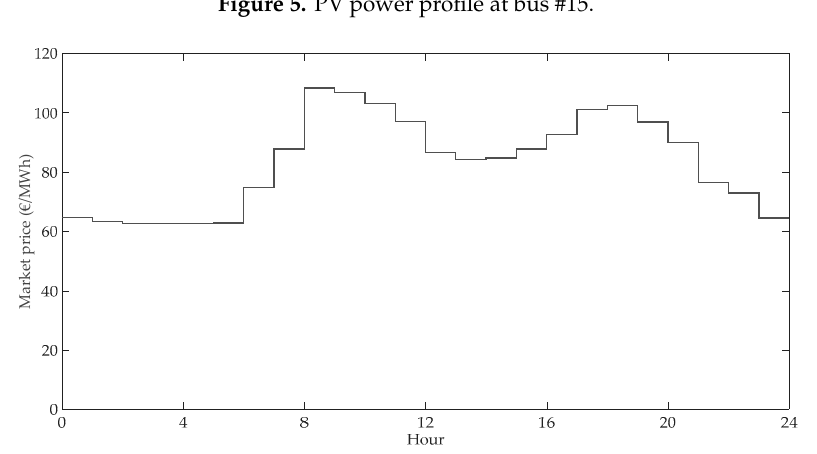
Figure 5. PV power profile at bus #15.